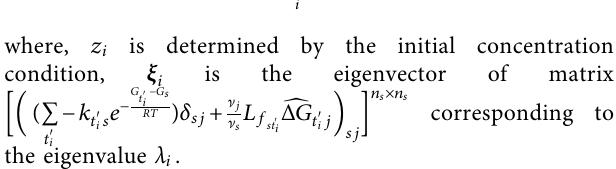
the eigenvalue λ i . According to the integral results of the time-dependent evolution of the network, the concentration change rates of different stable states are determined by the same set of (cid:31) A eigenvalues of the dynamic matrix , and a variety of λ i can be regarded as a variety of time evolution scale factors. All the stable states in the network evolute in the same power law, the only difference is the front multiplicative factors which are the components of eigenvector ξ i . These front multiplicative factors can be regarded as the weight coef fi cients of each time scale in different stable states. This is also an interesting fi nding. In ] evolve with the vector C addition, if we let the matrix [ k t i s and update by appropriate steps, the GITR theory would also be able to solve more complex non-linear kinetics problem.